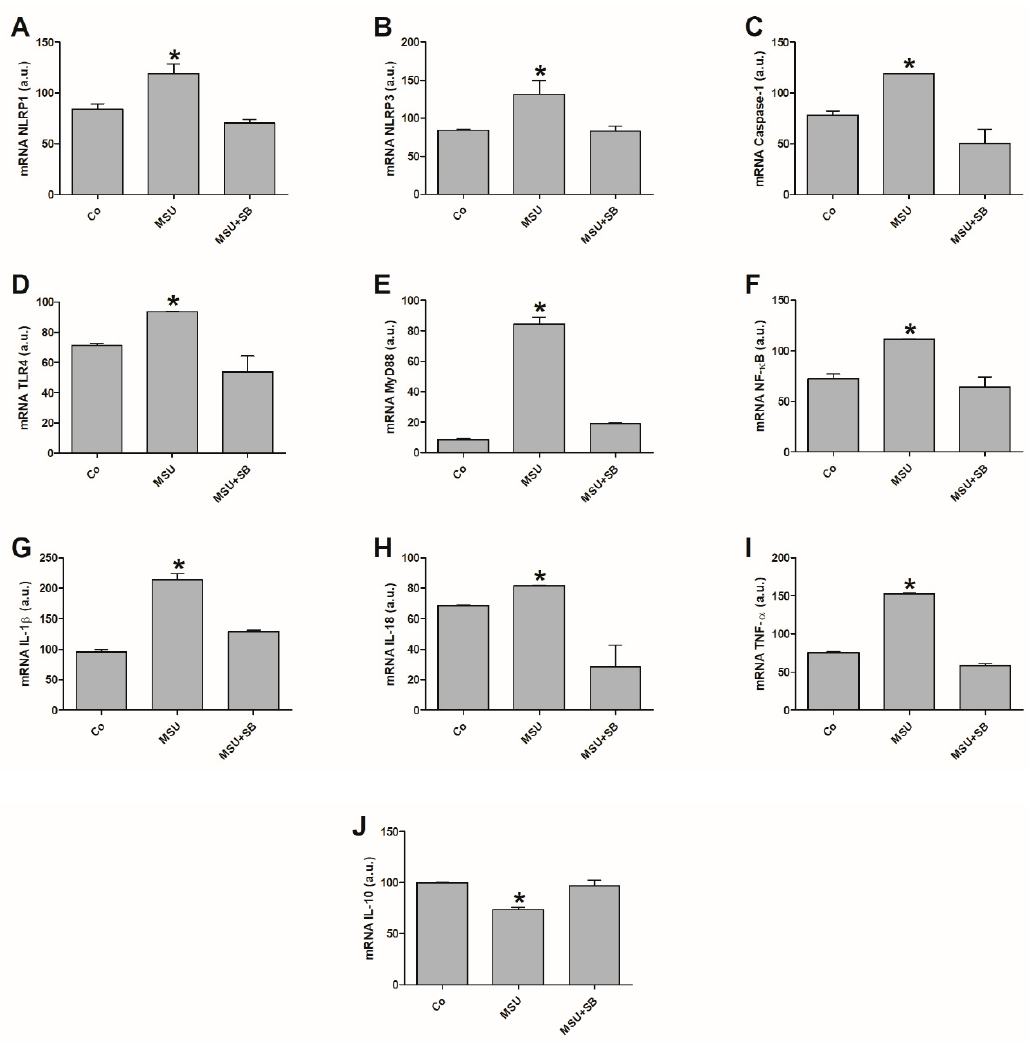
Figure 5. Gene expression of NLRP1 ( A ), NLRP3 ( B ), Caspase-1 ( C ), TLR4 ( D ), MyD88 ( E ), NF- κ B ( F ), IL-1 β ( G ), IL-18 ( H ), TNF- α ( I ) and IL-10 ( J ) in THP-1 cells cultured in the absence (Co) or presence of MSU or SB. Results, obtained from five independent experiments, are shown as mean ± standard deviation (SD) in arbitrary units (a.u.). * p < 0.05 vs. Co and MSU + SB (ANOVA).